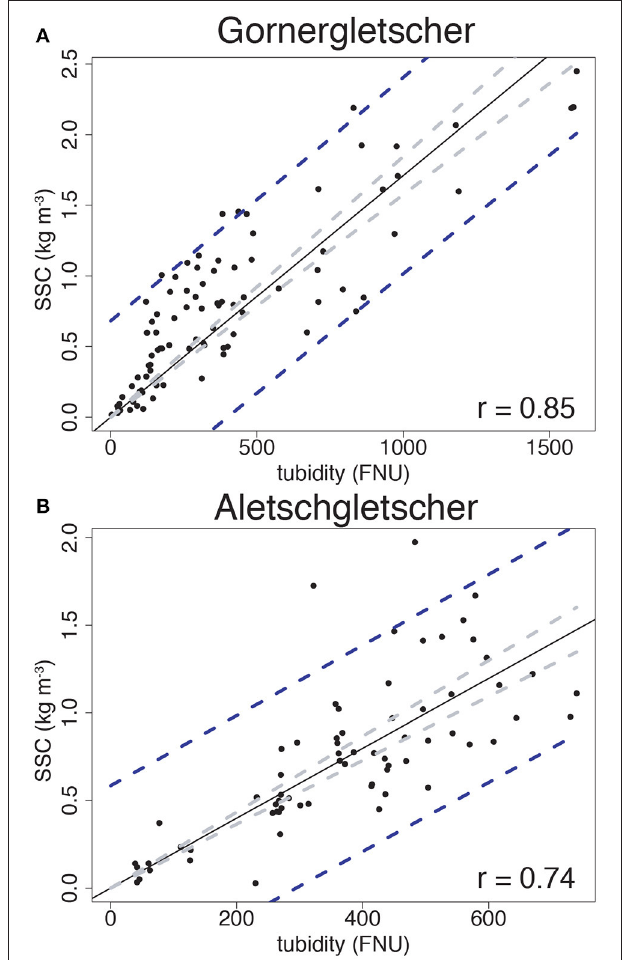
FIGURE 3 | Calibration relationship between turbidity (formazin nephelometric unit (FNU)) and suspended sediment concentration for Gornergletscher (A) and Aletschgletscher (B) . Black line represents best fit. Gray lines represent the 95% confidence interval. Blue lines represent the 95% prediction